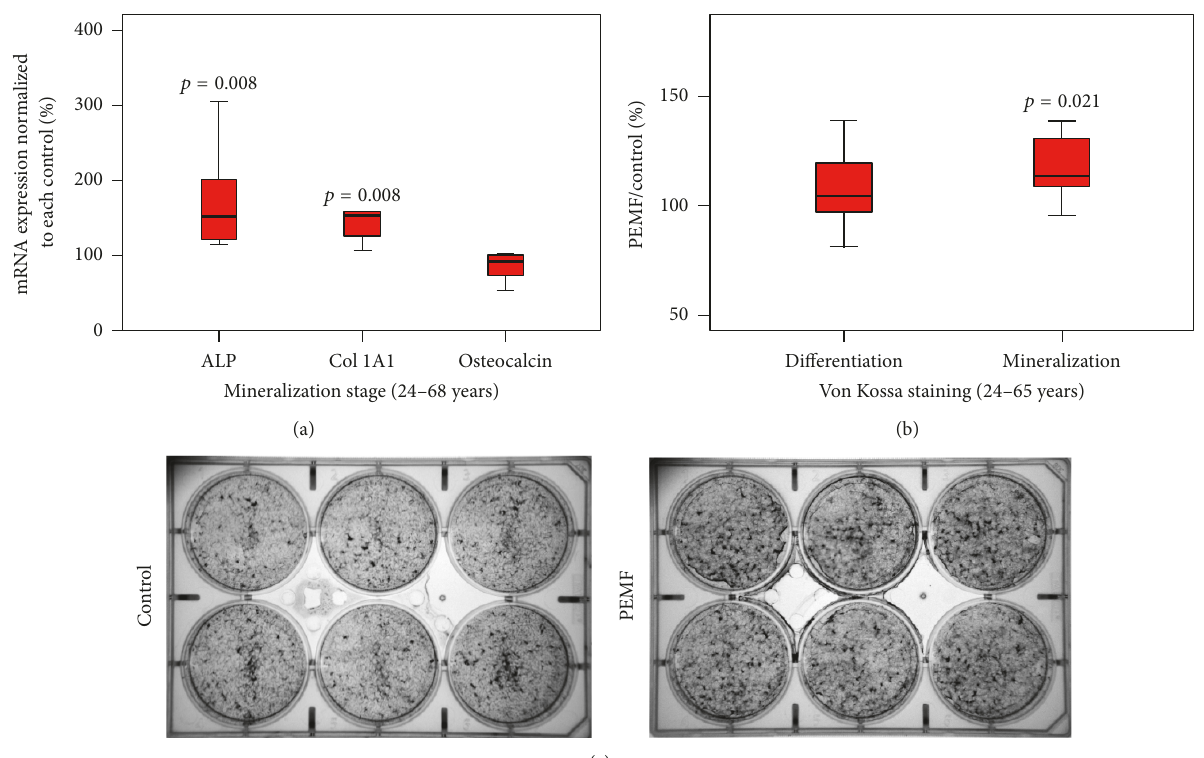
Figure 3: Effect of PEMF on expression of osteoblastic marker genes and mineralization in hBMSCs. Differentiating preosteoblasts from 24–68-year-old women were grown in the presence of osteoblast differentiation medium after confluence was reached and were treated with PEMF for 33 days or 43 days (59–68-year-old samples) of culture. (a) Total RNA was isolated and subjected to qRT-PCR using specific primers for human ALP, type I collagen, OC, and RPL13A. 𝑛 = 9 . (b) Cells were then subjected to Von Kossa staining and the mineralized calcium deposits were quantified. 𝑛 = 9 . Statistical analyses were conducted using Wilcoxon signed rank test. The 𝑝 value ≤ 0.05 is considered as significant compared with the controls. (c) An example of Von Kossa staining and mineralized calcium deposits for hBMSCs of a 24-year-old female after 33 days of osteogenic culture in the presence or absence of daily Cervical-Stim